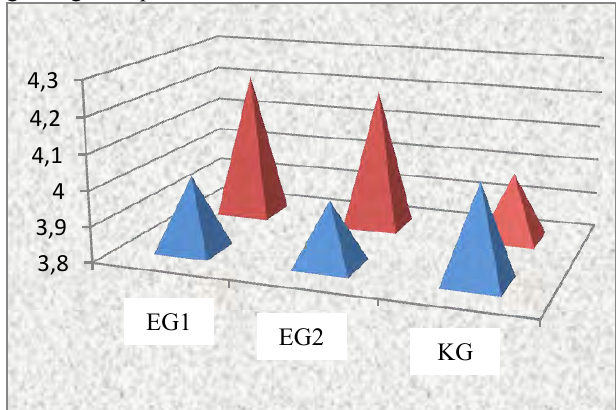
Fig.1. Speed of visual information processing (SVIP) at control and experimental